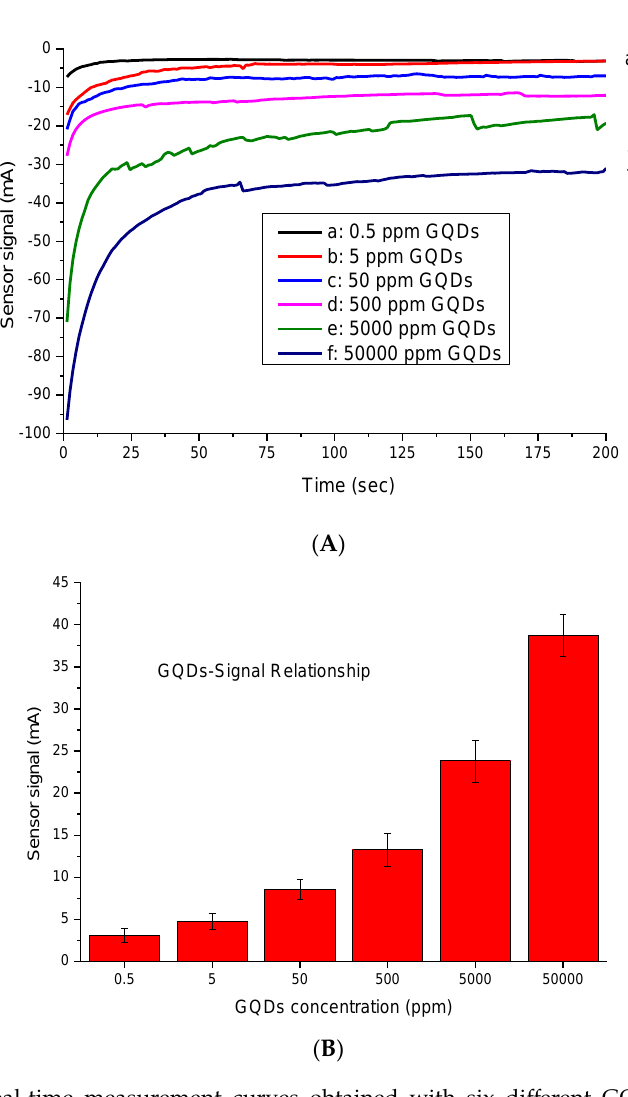
Figure 2. (A) Real-time measurement curves obtained with six different GQD concentrations. ( B ) Overall results of GQD optimization assays in a concentration range of 0.5 – 50,000 ppm (n = 3). The uniform size and morphology of the GQDs were confirmed by employing TEM (Figure 3).